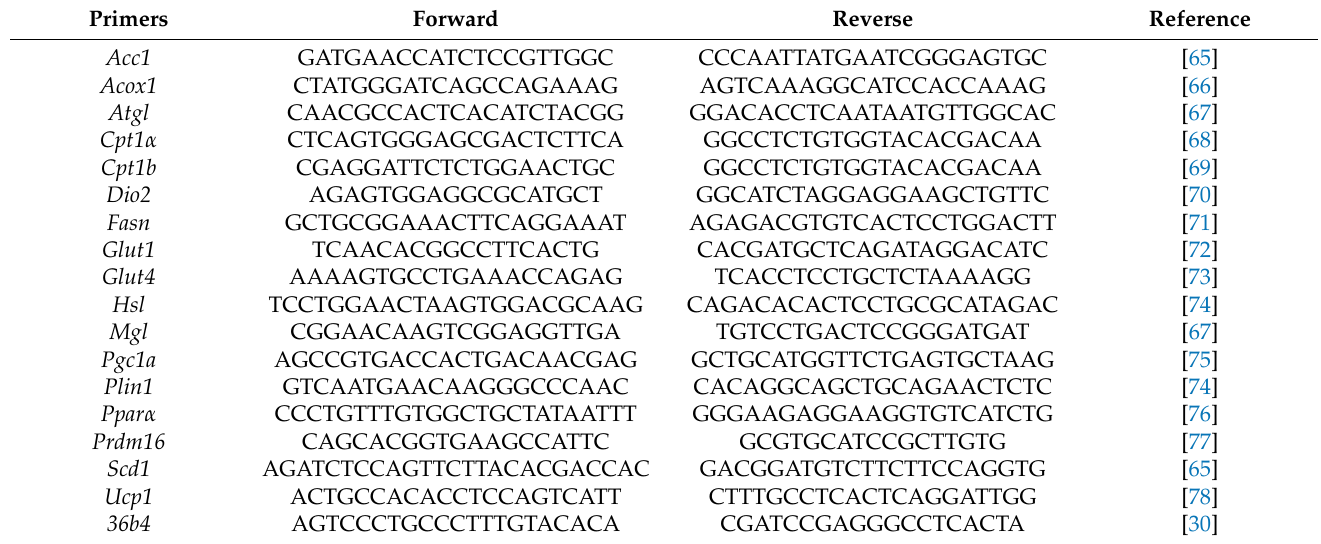
Table 1. Sequences of the oligonucleotides used in the